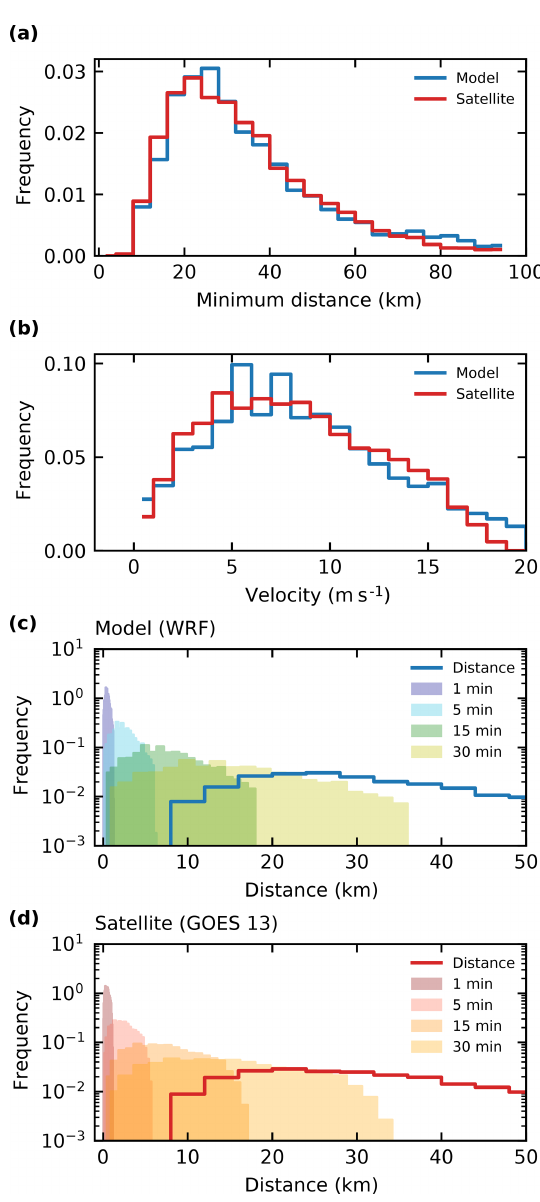
Figure 11. (a) Distributions of the distance to the next identified object for all identified objects and (b) velocities for tracked cloud objects at each time step of the trajectories for both the model sim- ulations and the satellite data. (d) The travel distance per input in- terval resulting from different time resolution of the input based on these velocities (b) is shown together with the distribution of the minimal distance to the nearest neighbour in (a) for the model data in (c) and for the satellite